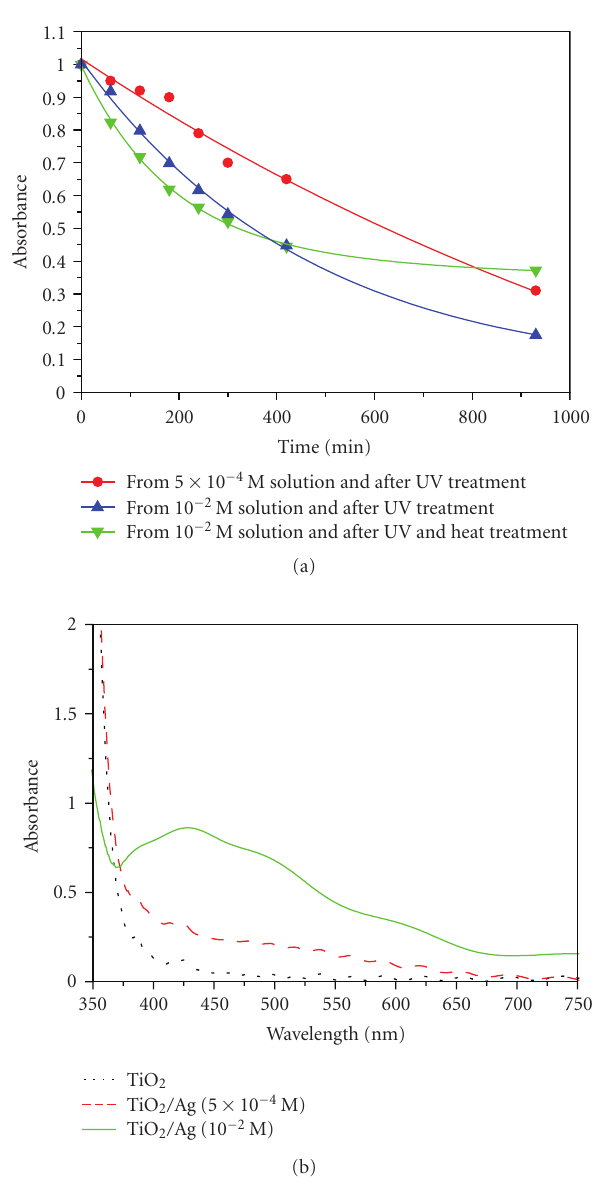
Figure 5: (a) Photodegradation curves of AZS with black light illumination in the presence of Ag modified TiO 2 films at various silver concentrations and treatments of the films: (a) - • - from 5 × 10 − 4 M solution and after UV treatment; (b) - (cid:2) - from 10 − 2 M solution and after UV treatment; (c) - (cid:3) - from 10 − 2 M solution and after UV and heat treatment.